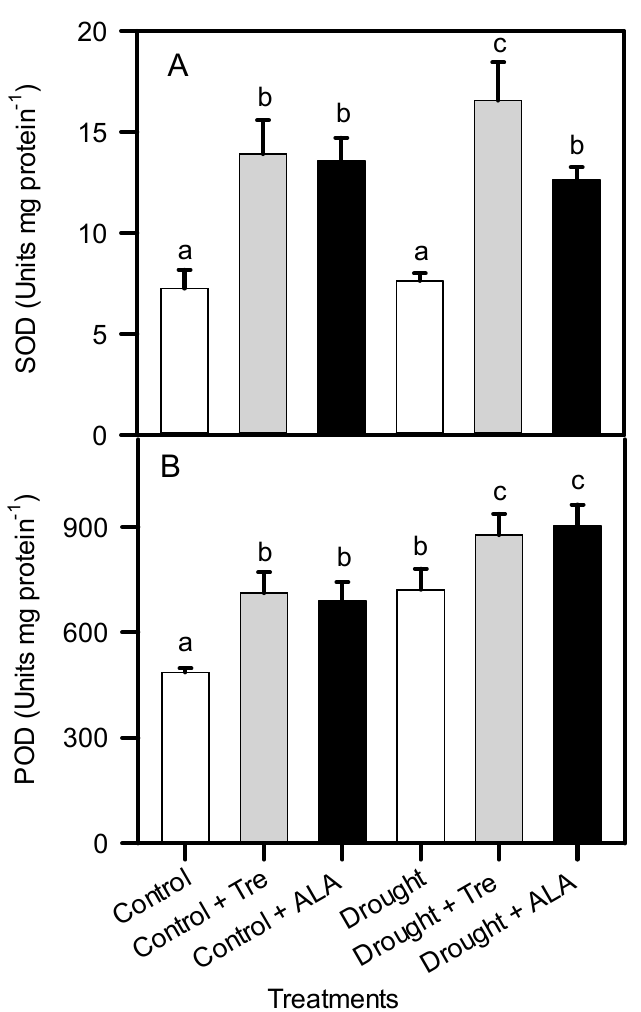
Figure 6. Superoxide dismutase (SOD) ( A ) and peroxidase (POD) ( B ) activity in leaves of well-watered (100% FC, Control) and drought-stressed (65% FC, Drought) Alpinia zerumbet treated with foliar applications of water alone, 25 mM trehalose (Tre) or 10 mg L − 1 5-aminolevulinic acid (ALA). Values are means ± S.E. ( n = 6). Different letters above the bars indicate significant differences based on LSD analysis at p < 0.05.